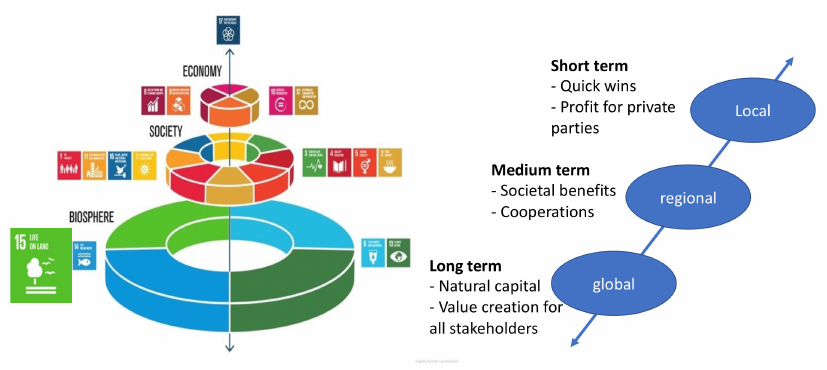
Figure 1. Scheme depicting the spatial and temporal effects and lock-ins in our current, profit-driven, linear economy, with the three sets of the SDGs (economy, society, biosphere). Left hand picture adapted after the original of the Stockholm Resilience